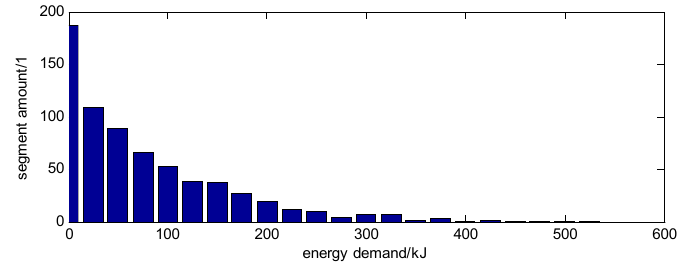
Figure 6. The distribution of demand energy value in charge condition.